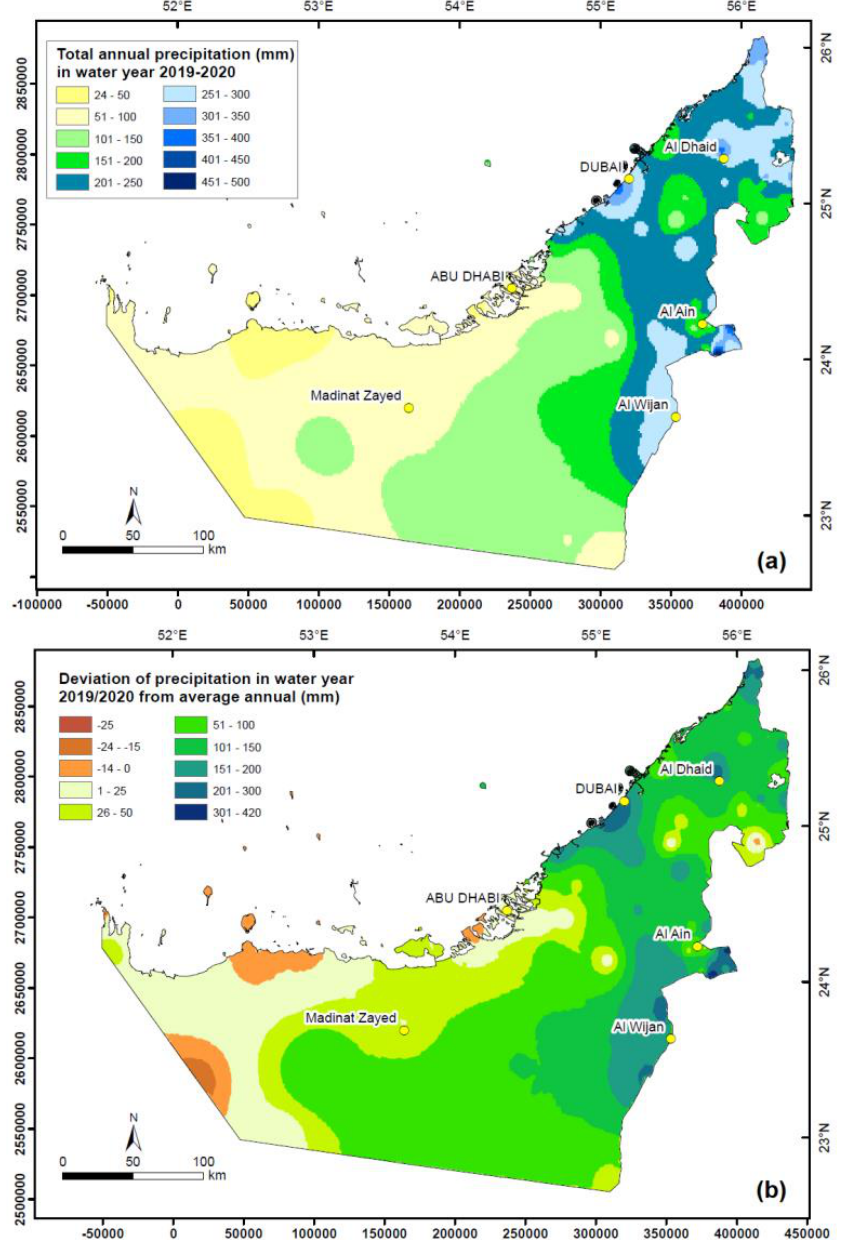
Figure 2. ( a ) Annual average precipitation (mm) in the UAE in the water year 2019–2020 and ( b ) deviation of annual average precipitation (mm) in the UAE in the water year 2019–2020 from average annual precipitation in the period